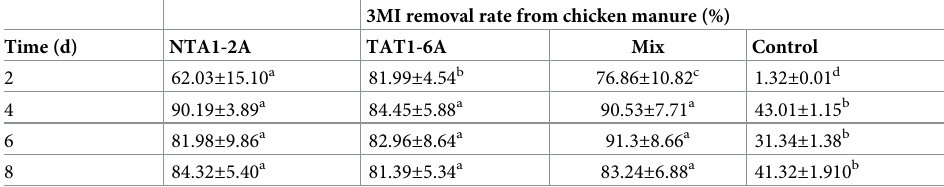
a, b,c,d means values with different letters in a row show the strains are significantly different (P < 0.05) in their ability to remove 3MI from